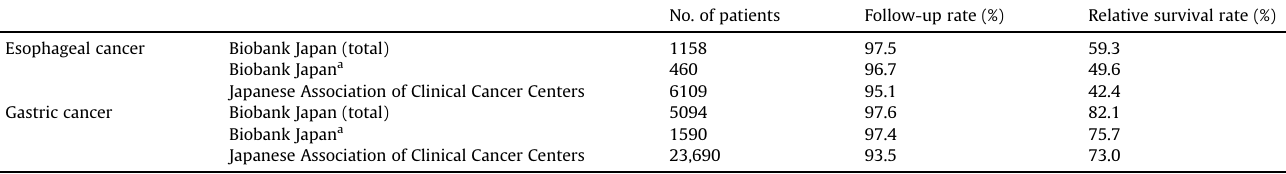
Table 2 Five-year relative survival rate of patients with esophageal and gastric cancer.